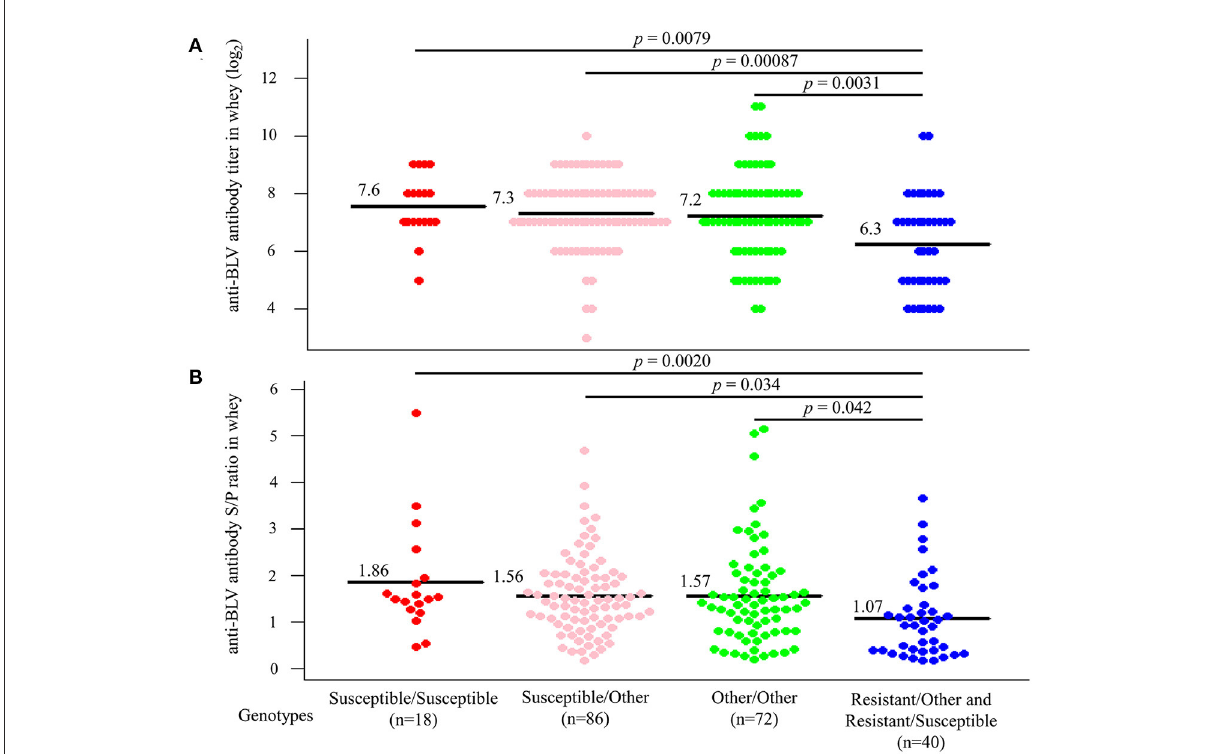
FIGURE6 Differences in the amount of anti-bovine leukemia virus (BLV) antibodies in whey according to genotypes. All dams were divided into Susceptible/Susceptible, Susceptible/Other, Other/Other, and Resistant/Other or Susceptible based on genotypes. (A,B) Anti-BLV antibody titers (A) and S/P ratios at 32-fold dilution (B) in whey for each genotype. Anti-BLV antibody titers and S/P ratios at 32-fold dilution in whey were measured using an anti-BLV antibody ELISA. Mean anti-BLV antibody titers and S/P ratios among groups were compared using Tukey’s multiple comparison